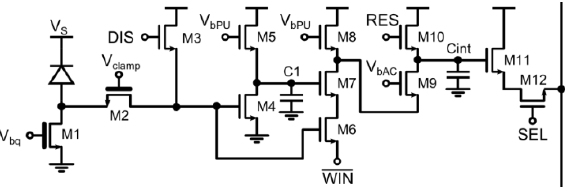
Figure 6. Time-gated pixel with analog counter, enabling gating windows from ≈1 ns up to several hundreds of milliseconds [19].